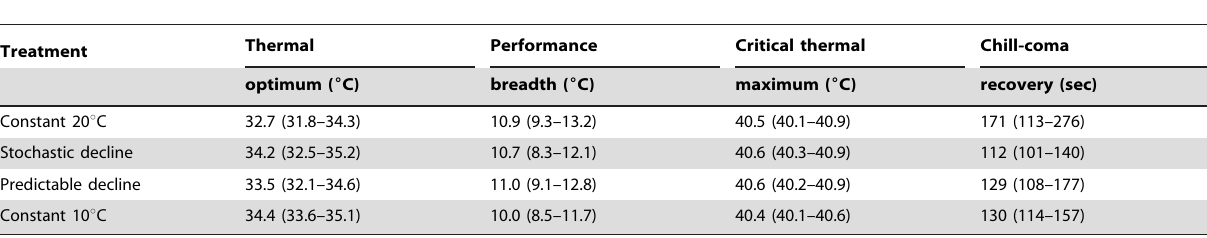
Table 2. Thermal optima, performance breadths, and critical thermal maxima were similar for all treatment groups, but chill-coma recovery times varied significantly among